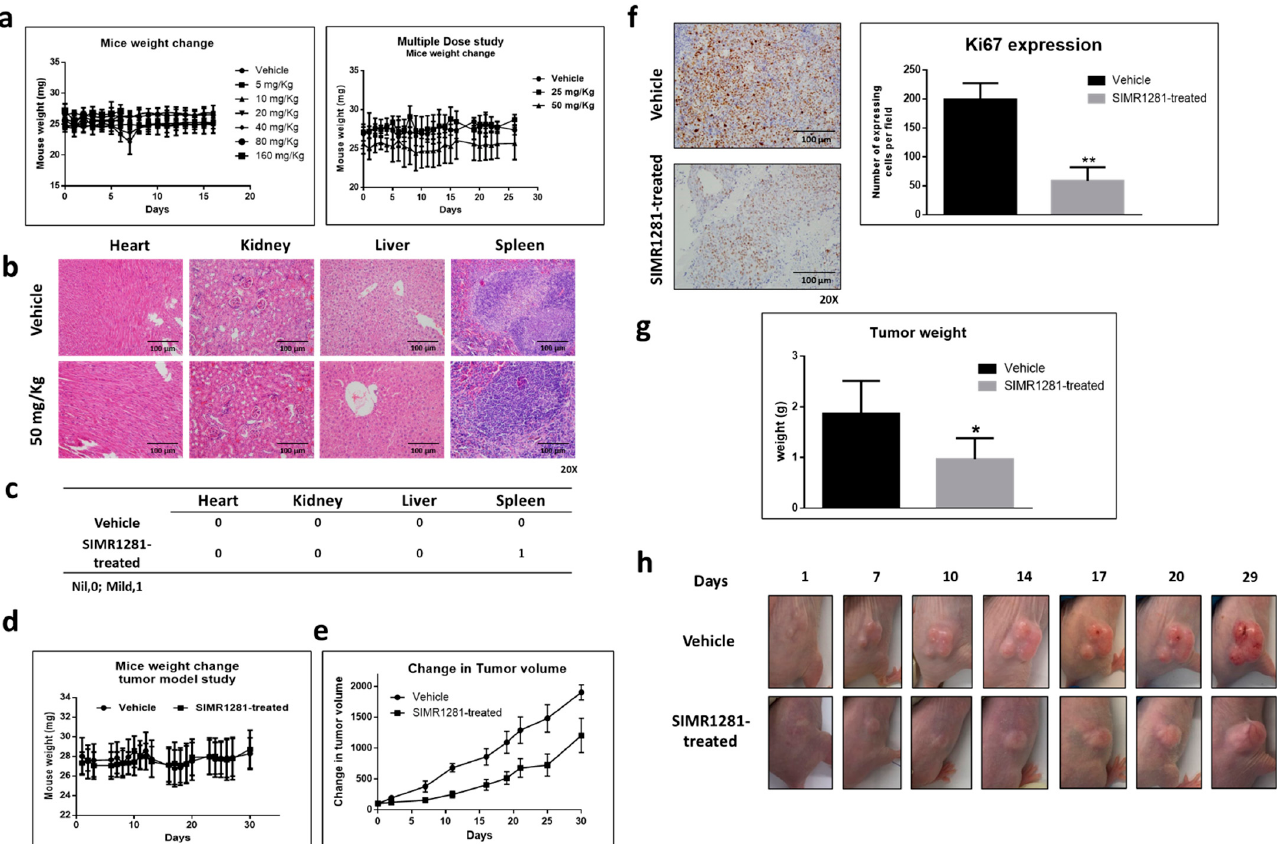
Figure 5. SIMR1281 is safe at high doses, and it significantly attenuated the proliferation of HCT116 tumor model in nude mice. ( a ) Mice weight change over the indicated period during the treatment in single- and multiple-dose studies of SIMR1281. Mean; bars, SD ( n = 3). ( b ) Representative figures of H&E staining (scale bar 100 µm) for SIMR1281-treated (50 mg/kg) and control mice groups. ( c ) Table displaying the toxicity score for SIMR1281-treated (50 mg/kg) and control mice groups. ( d ) Mice weight change during treatment. Mean; bars, SD ( n = 5–7). ( e ) Change in tumor volume throughout the 30 days of treatment with SIMR1281. Mean; bars, SD ( n = 5–7). ( f ) The mean of Ki67 expressing cells. Representative pictures of IHC for Ki67 expression in the tumor tissues (scale bar 100 µm) after the treatment with 50 mg/kg of SIMR1281. Columns, mean; bars, SD ( n = 5–7). ** Indicates a significant difference versus control at p < 0.05 determined by a two- tailed unpaired t -test. ( g ) Tumor weight of the vehicle and SIMR1281-treated group. * indicates a significant difference versus control at p < 0.01. ( h ) Representative pictures of tumor progression in SIMR1281-treated and control groups.